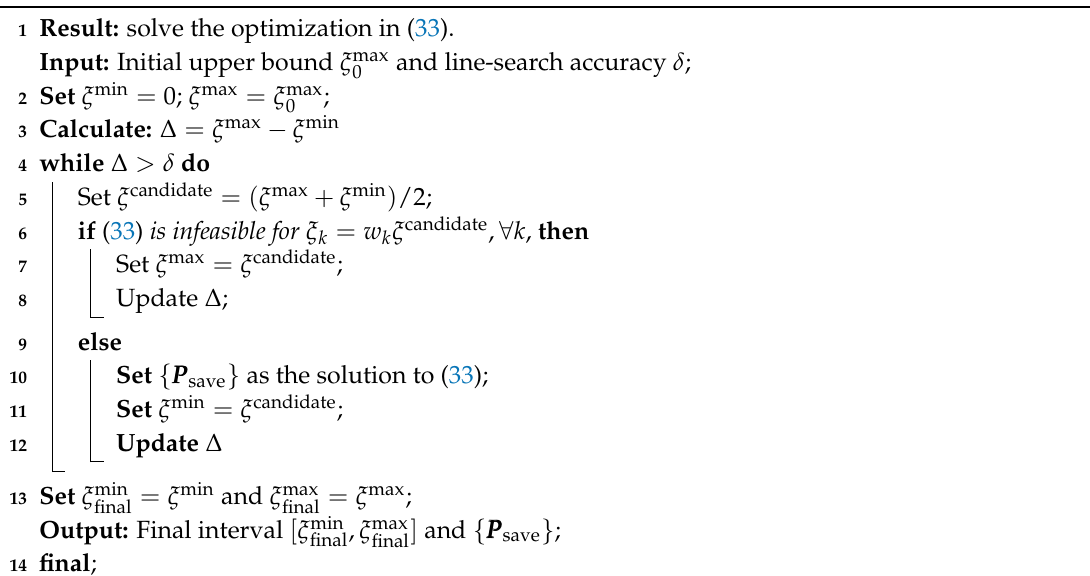
Algorithm 1: Max–min quality of service (QoS) based on the bisection